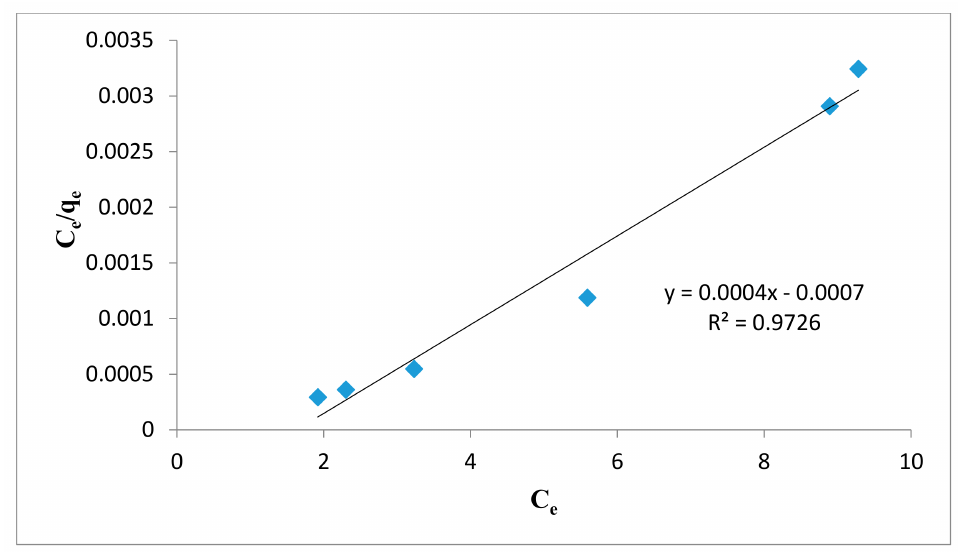
Figure 12. Freundlich Isothermal study.